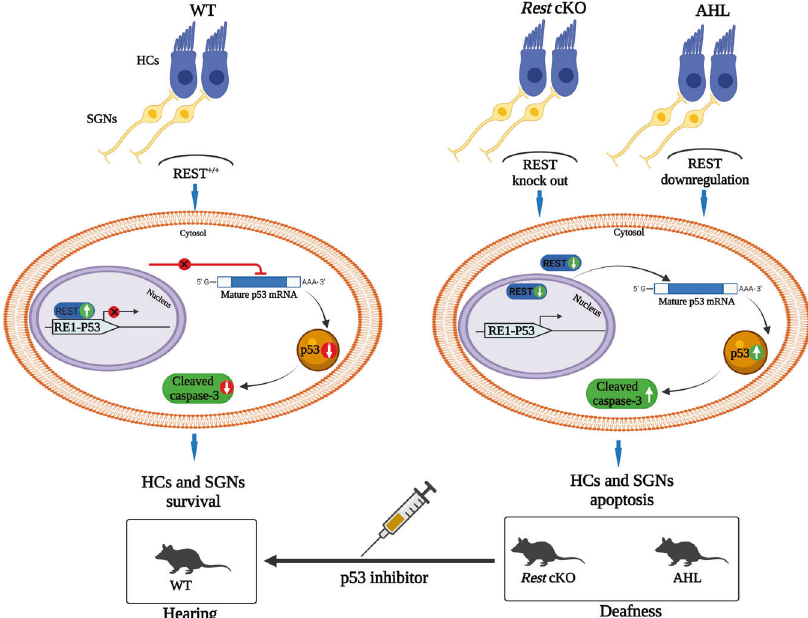
Fig. 8 Model for mechanisms of REST downregulated induced apoptosis of SGNs and HCs through p53 pathway contribute to AHL. In WT mice, REST inhibits P53 expression, which allows HCs and SGNs exert their normal functions, and thus preserve proper hearing. In contrast, in the cochleae of Rest cKO mice or AHL mice, REST expression was decreased, resulting in reduced inhibition of P53. The high level of p53 leads to apoptosis of SGNs and HCs, and therefore hearing loss in those mice. Administration of p53 inhibitor improved hearing in Rest cKO and AHL